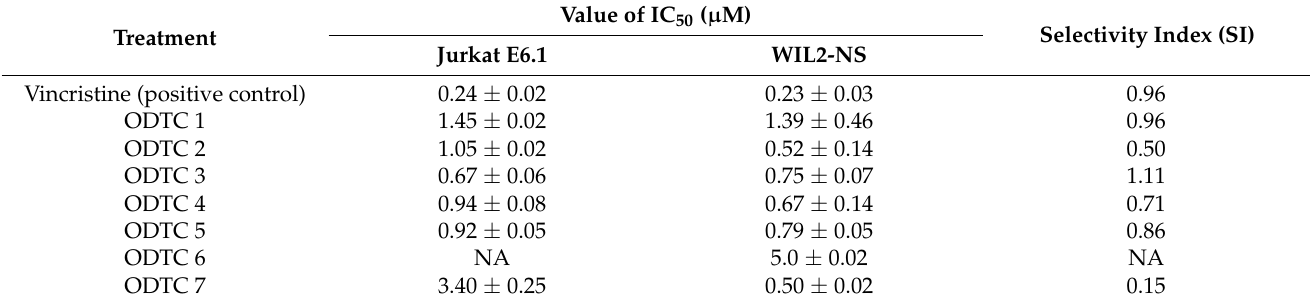
Table 1. The IC 50 values of organotin(IV) dithiocarbamate compounds and vincristine against Jurkat E6.1 cells.